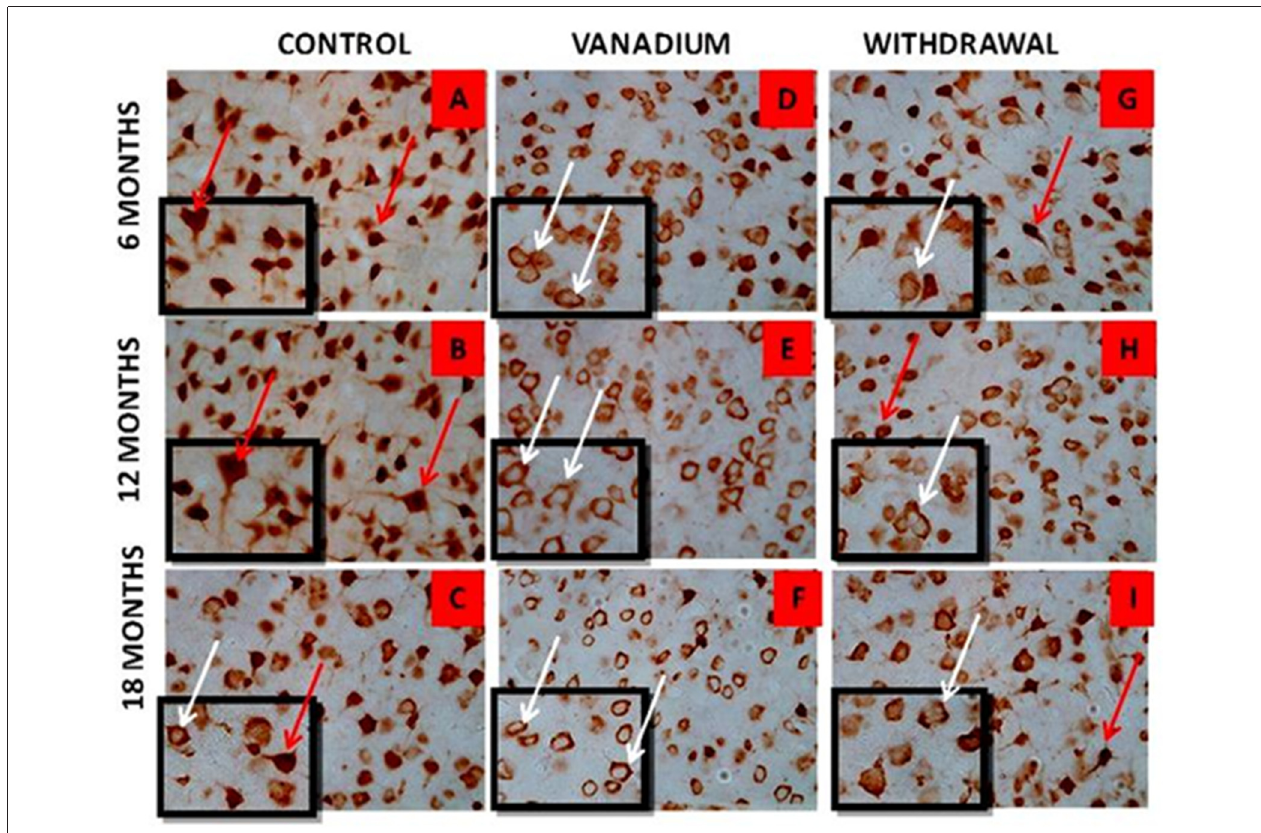
FIGURE 6 | NeuN immuno-histochemistry revealed the cytotoxic effect of vanadium on the pyramidal cells of the prefrontal cortex after chronic exposure. The cortical pyramidal cells showed morphological alterations including pyknosis, cell clustering, loss of layering pattern and cytoplasmic vacuolation in the vanadium exposed groups (white arrows in B,E,H ) relative to the control (red arrows in A,D ) with normal neuronal morphology. The withdrawal groups (C,F,I) showed reversal effect with less cellular toxicity relative to vanadium exposed groups. The vanadium cytotoxicity was also observed in the aged control mice brain (white arrows in G ), indicative of neuronal degeneration seen also at early vanadium exposure. Magnification: × 400, inset: ×